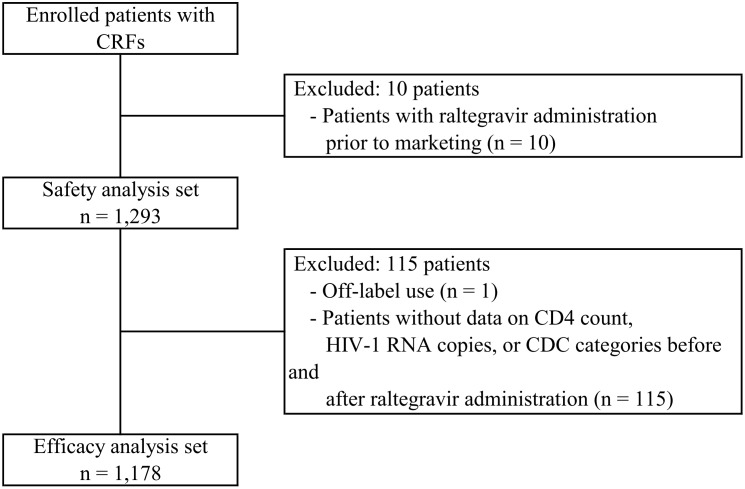
Patient disposition.CRF: case report form, CDC: Centers for Disease Control and Prevention.